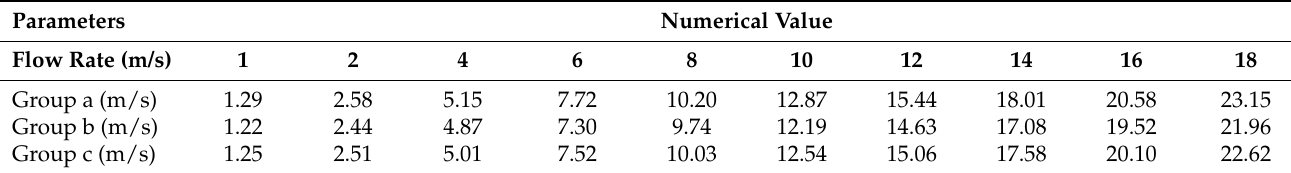
Table 2. Maximum flow rate values inside the three water ‐ cooled plates at different inlet flow rates.